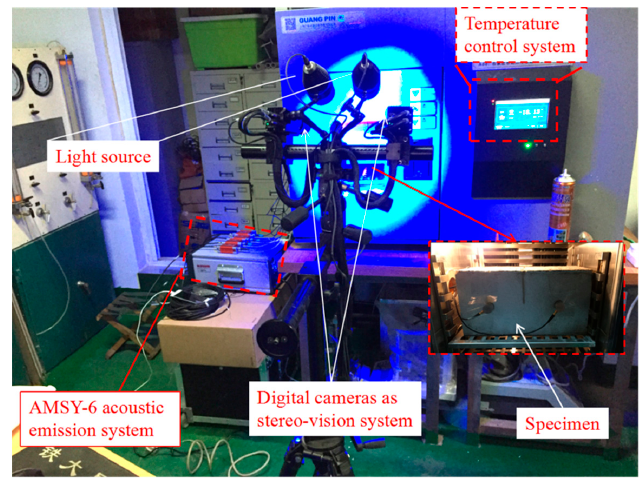
Figure 3. Experimental set-up.